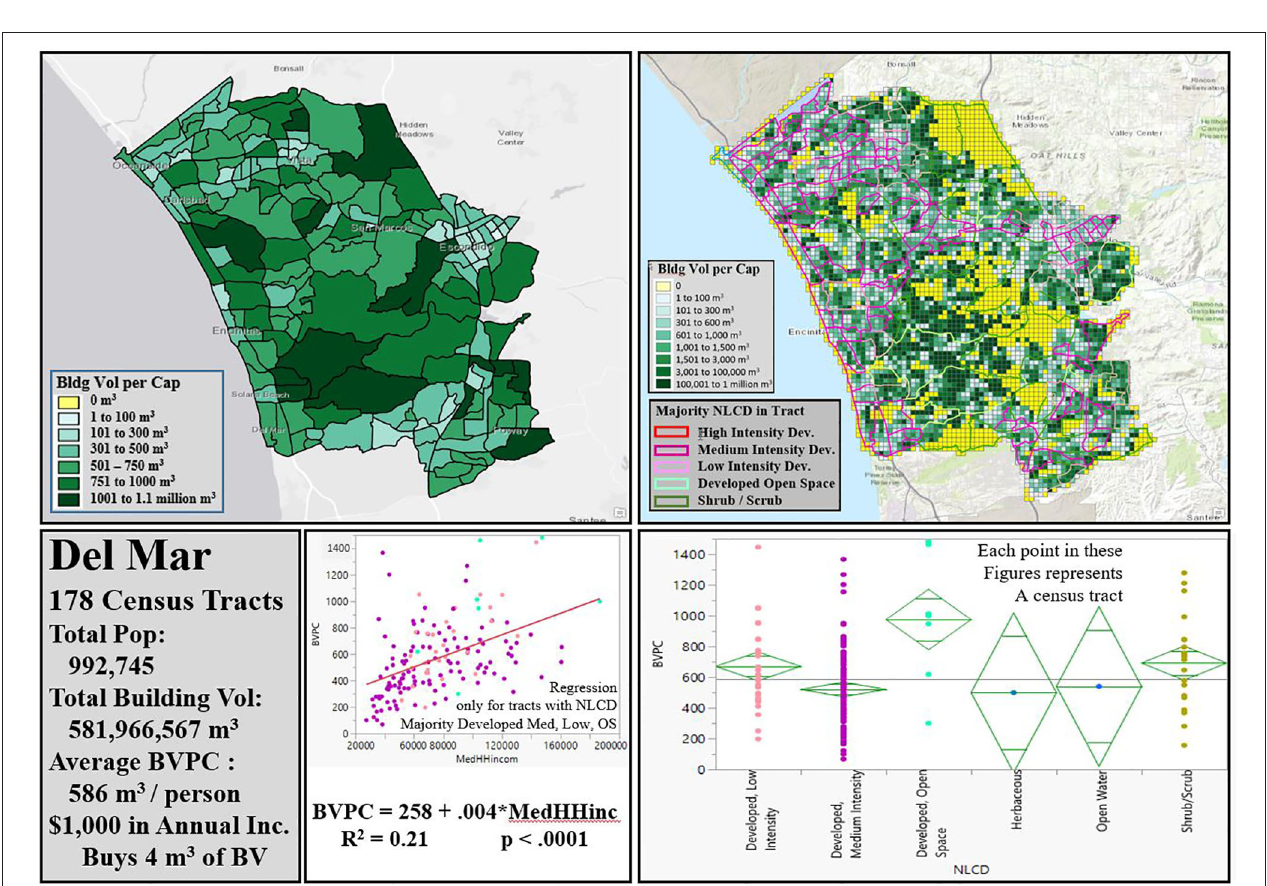
FIGURE 3 | Census tract and raster cell representation of BVPC for Del Mar, California.